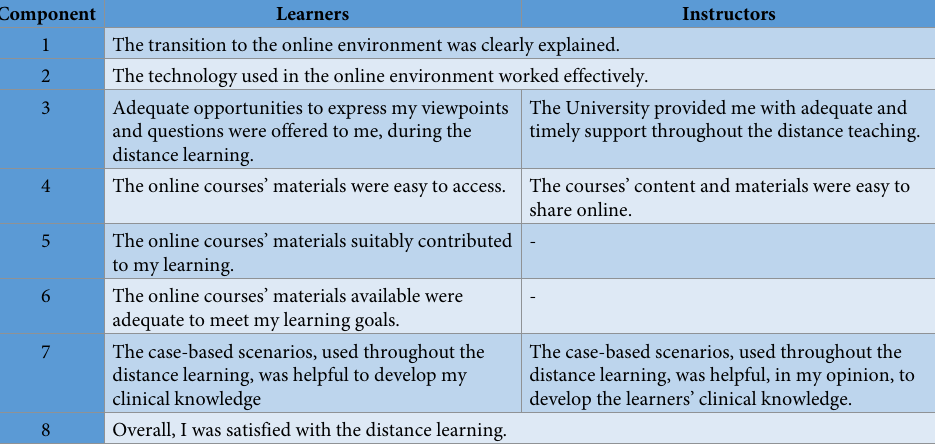
Table 1. Description of the first segment of the survey that captured the perceptions of the learners and instructors. Component Learners